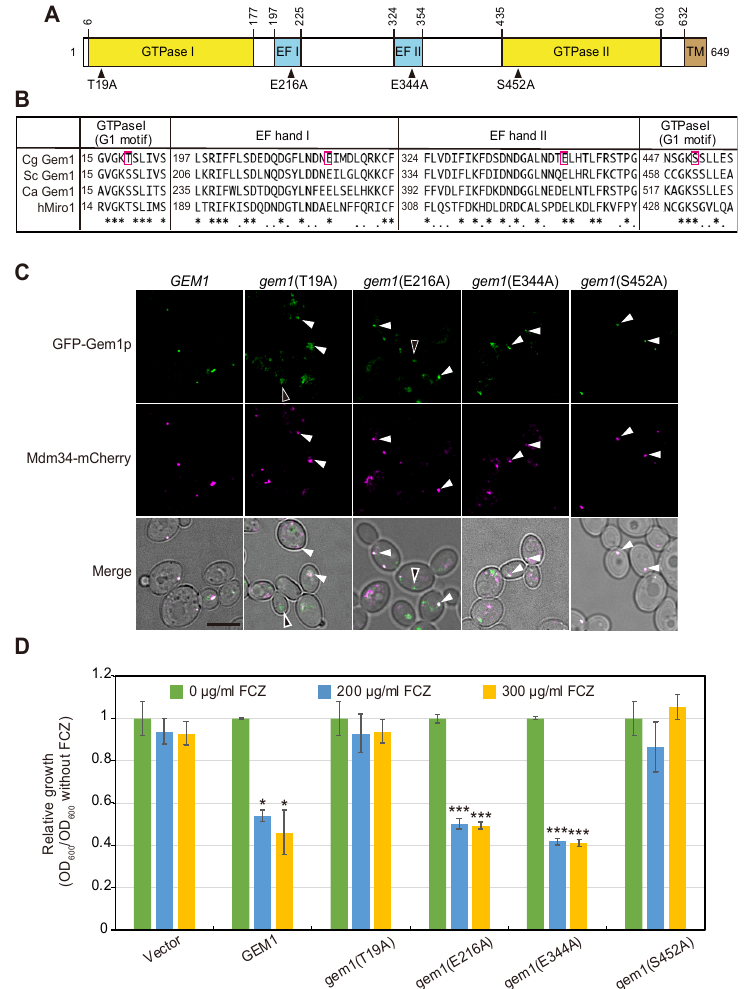
Figure 4. Domain structure of Gem1 and the effects of domain mutations on azole susceptibility. ( A ) Schematic diagram of Gem1, containing 2 putative GTPase domains (GTPase I and II), 2 EF ‐ hand motifs (EF ‐ hand I and II), and a transmembrane domain (TM). The positions indicated by arrows indicate the amino acid substitution sites. ( B ) Sequence alignment of the predicted GTP ‐ binding